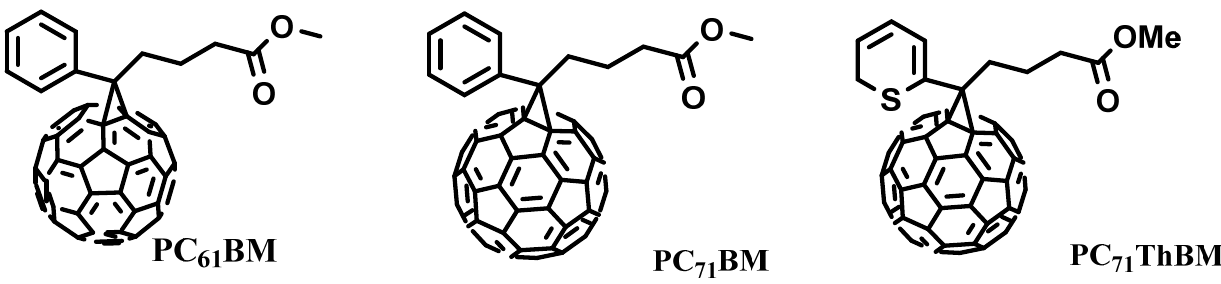
Figure 2. Representative chemical structures of fullerene derivatives.